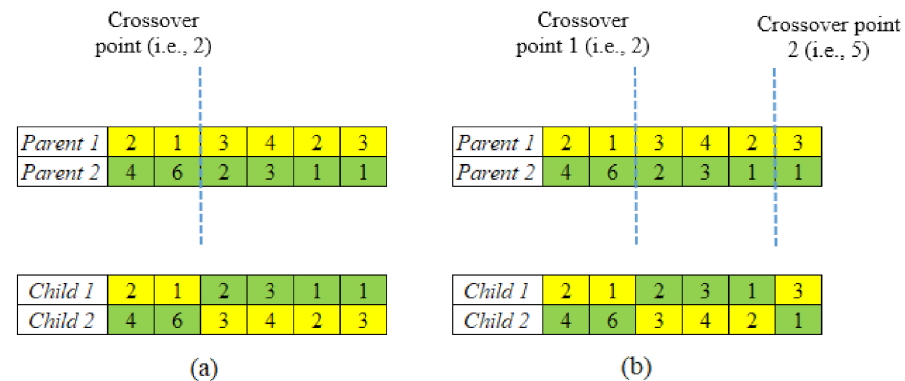
Figure 3. Operation of ( a ) single-point crossover; ( b ) two-point crossover. An arbitrary crossover location was chosen in this one-point crossover, and the ends of its two parents were exchanged to produce new offspring [85,88]. Two-point crossover, which is an extension of single-point crossover, involves the swapping of alternating segments to get new off-spring. The crossover procedure for a pairing of chromosomes containing six genes is as